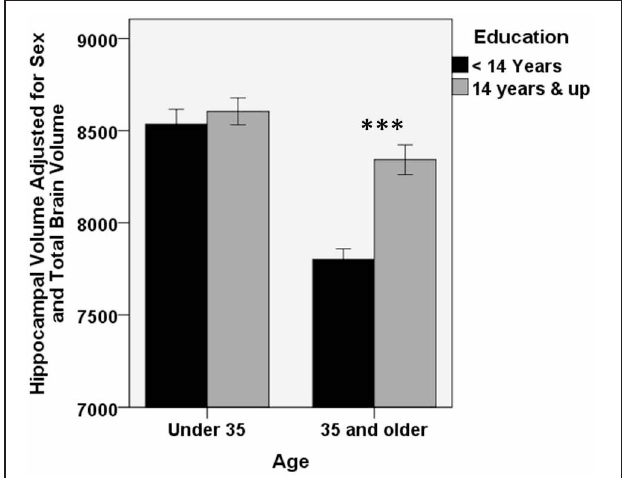
FIGURE 2 | Higher educational attainment buffers age-related decrease in hippocampal volume. A significant education × age interaction is present for hippocampal volume (Beta = 0.498 p < 0 . 001), such that age-related decline in hippocampal volume is smaller among individuals with higher educational attainment. For clarity of presentation, educational attainment and age are represented graphically by median split. There was no difference in hippocampal volume according to education in the younger half of the subject pool. However, among older participants, more highly educated individuals had significantly larger hippocampi ( ∗∗∗ p < 0 . 0001). Error bars represent ± 1 standard error.